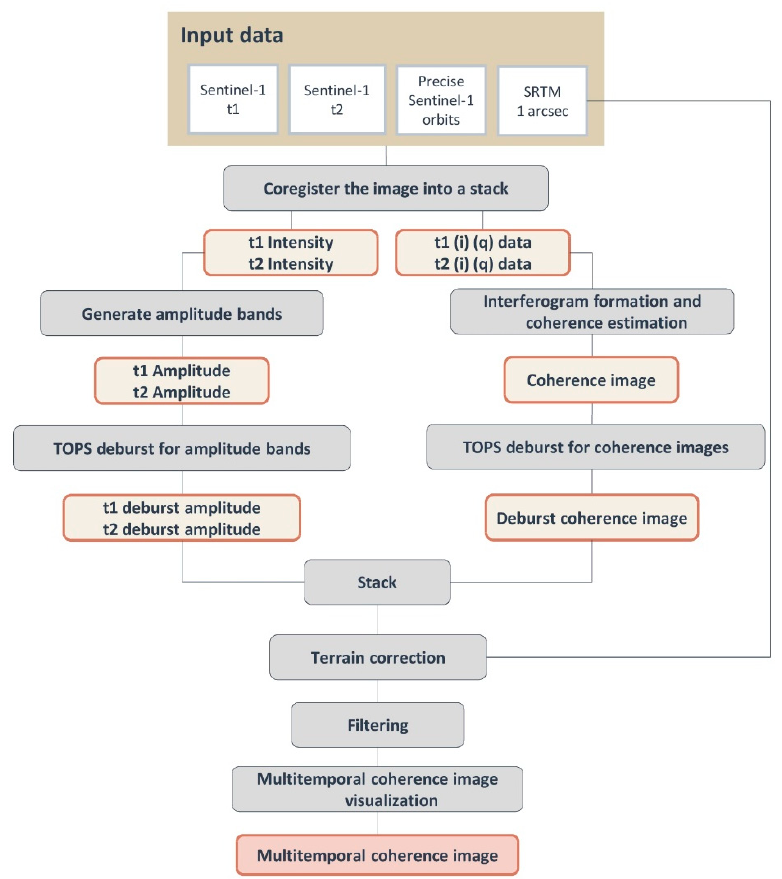
Figure 2. The workflow of the Sentinel-1 image processing in order to obtain the MultiTemporal Coherence image (MTC) analysis.